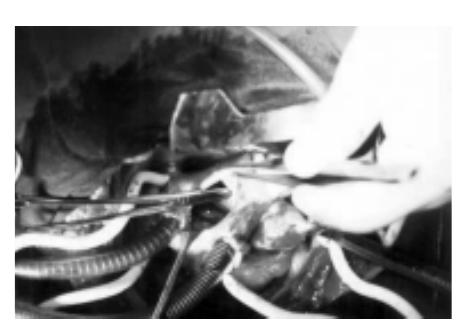
The transthoracic echocardiogram is the most-used non- invasive diagnostic method in heart lesions, with transoesophageal echocardiogram being used when the clinical condition of the patient allows. This is more specifically used to visualize the mechanism of the lesion, the valvar anatomy, the myocardial function and the presence of associated lesions such as interatrial communication [10,11]. Initial hemodynamic instability, as well as, the lack of the appearance of the murmur did not prompt the performing of a transoesophageal echocardiogram. The transthoracic echocardiogram performed on the 15th day of hospitalization in the intensive care unit only showed slight aortic incompetence, so the patient was released from hospital after a clinical improvement. With the appearance of dyspnea and signs of congestive heart failure three months after the accident the transthoracic echocardiogram was repeated which compared to the previous examination demonstrated severe aortic incompetence, moderate mitral incompetence, an increase in the left and right heart chambers and left ventricle dysfunction. A transoesophageal echocardiogram was indicated which showed the dis-insertion of the non- coronary cuspid, as well as interatrial septum rupture (Figures 4 and 5). The patient was submitted to coronary cineangiography to exclude coronary artery lesions and referred to surgical treatment. The surgical indication should be made as fast as possible, after establishing the diagnosis, to avoid greater damage to the myocardium.